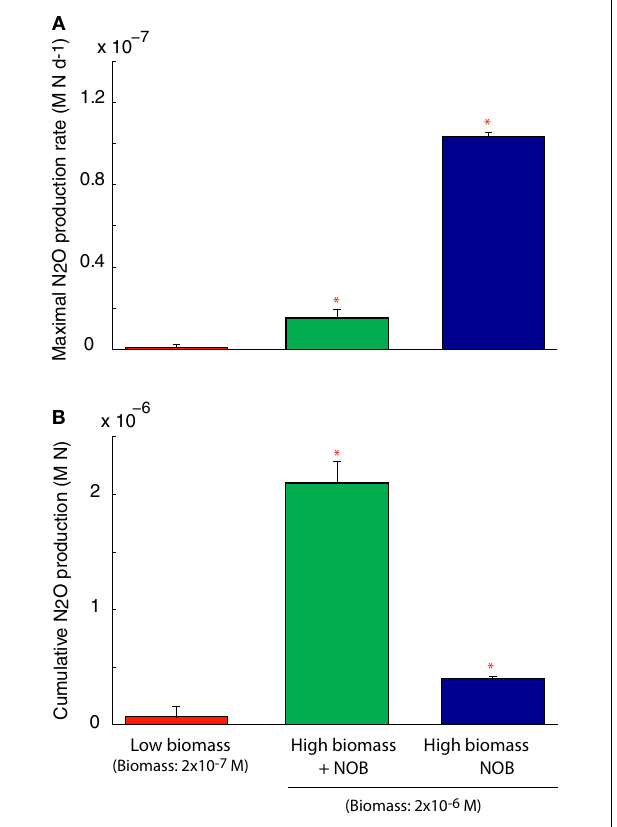
FIGURE 3 | Mean trait-valueAOO community diversity and activity across a temperature gradient. (A) Stacked bar chart depicts community diversity as a proportional contribution to the total community biomass.The evenness value is given above the plot. (B) Rates of NH 3 oxidation (bar chart) and gross N 2 O production (line graph). Error bars are the result of multiple simulations ( n = 3).